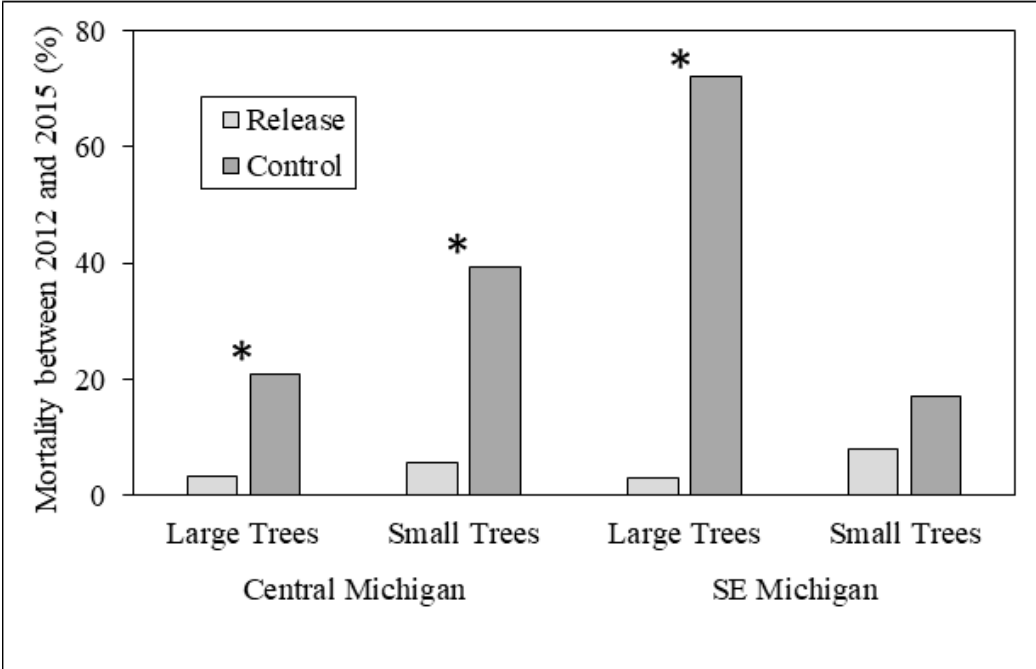
Figure 3. Tree mortality between 2012 and 2015 in release and control plots in central and southeastern Michigan study sites. Differences between release and control plots were significant for large trees in both central and southeastern Michigan ( p < 0.001 for both), and were nearly significant ( p = 0.058) in central Michigan for small trees. Asterisks indicate significantly different comparisons between release and control plots.